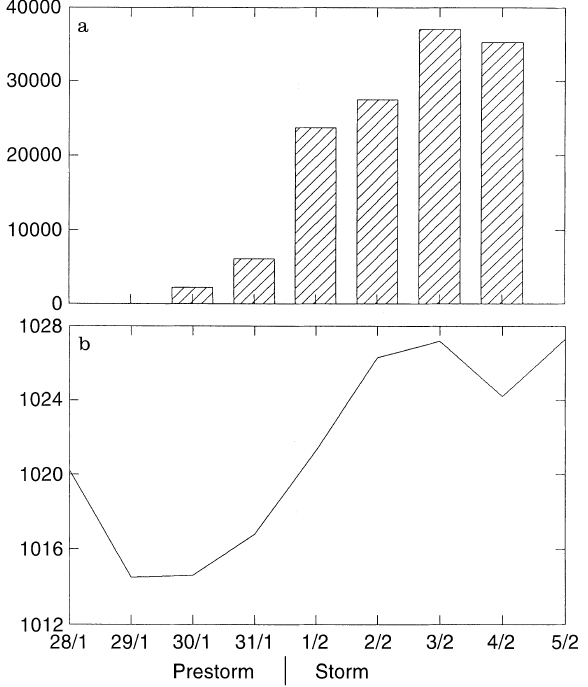
Fig. 4. Skew T-logp plot of Murcia sounding for 1200 UTC on 29 January 1993. Solid line is the temperature plot ( (cid:176) C); dashed line is the dewpoint plot ( (cid:176) C); wind barbs are in